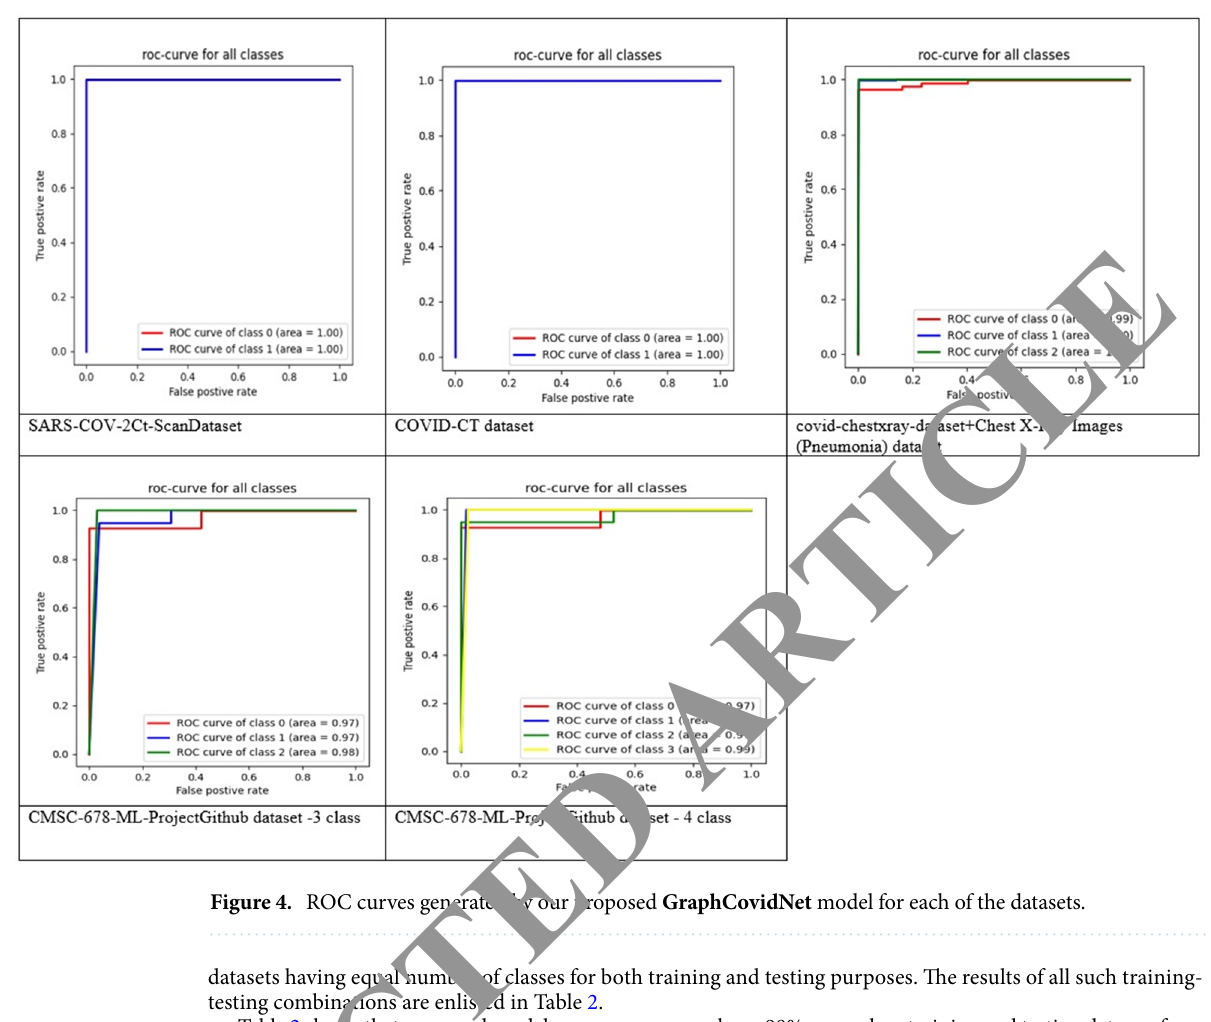
Figure 4. ROC curves generated by our proposed GraphCovidNet model for each of the